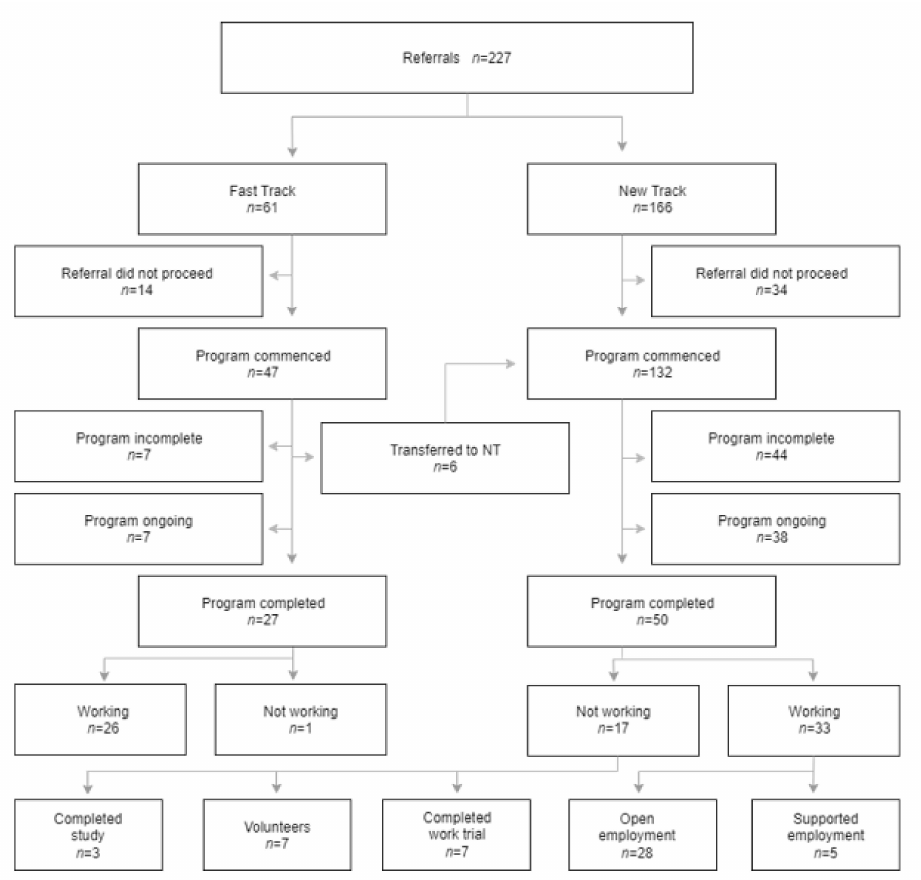
Figure 2. VIP 2.0 participant flow